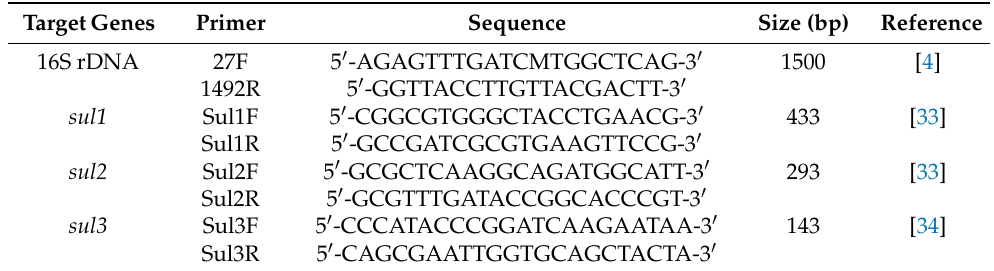
Table 1. Primers sequences for SAR isolates identification and sul genes